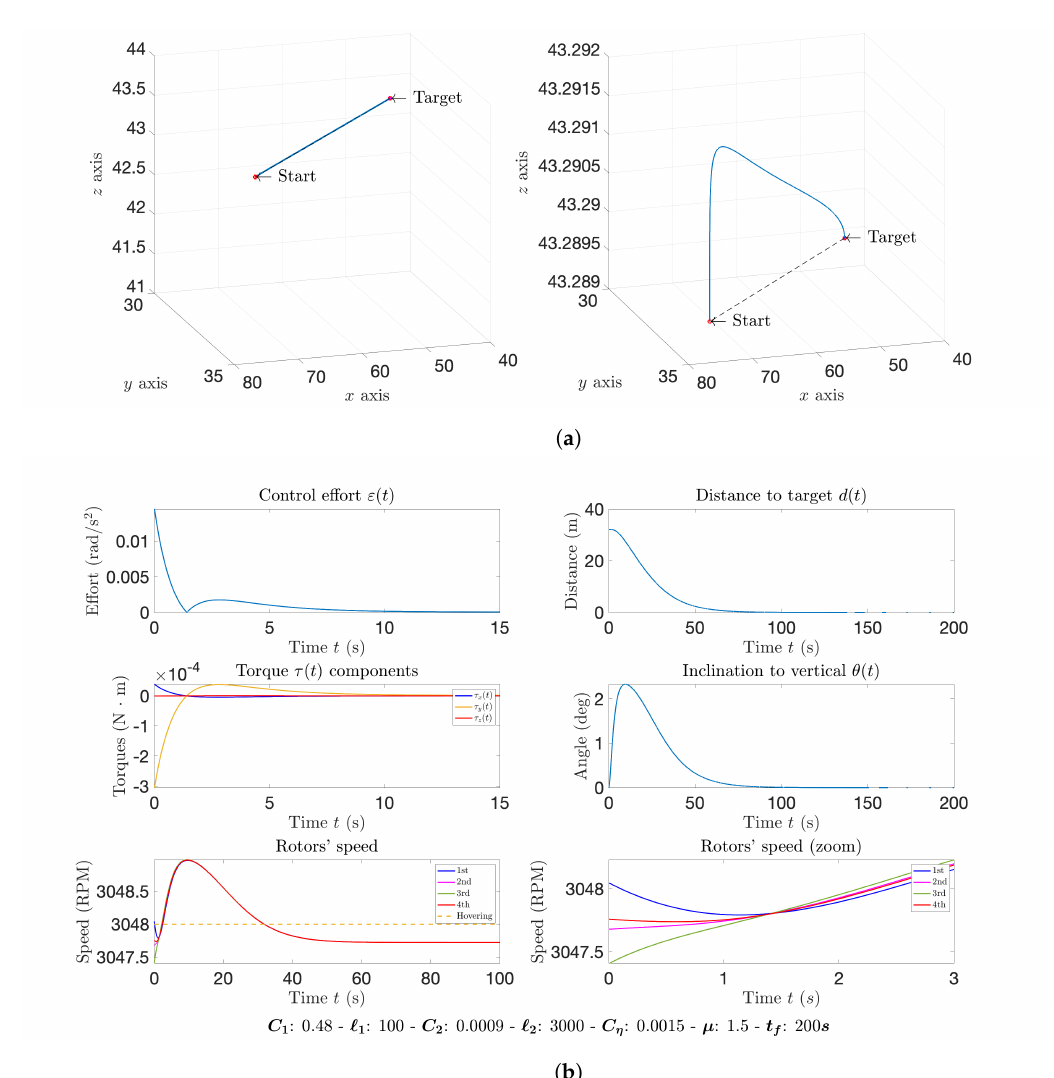
Figure 6. Experiment: Horizontal displacement, favorable initial conditions. ( a ) Target approach- ing trajectory; ( b ) Control